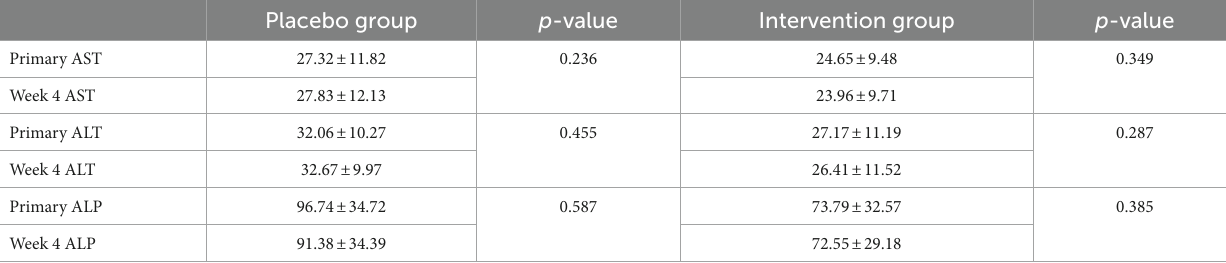
TABLE 2 Laboratory values of the participants throughout the study. Placebo group p -value Intervention group p